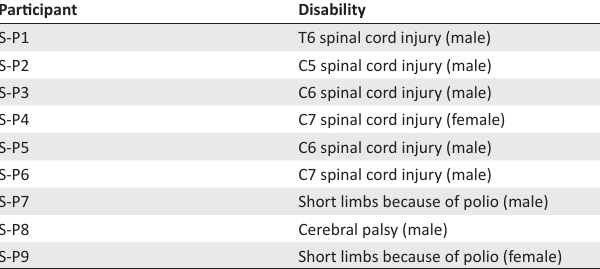
TABLE 3: Characteristics of South African participant